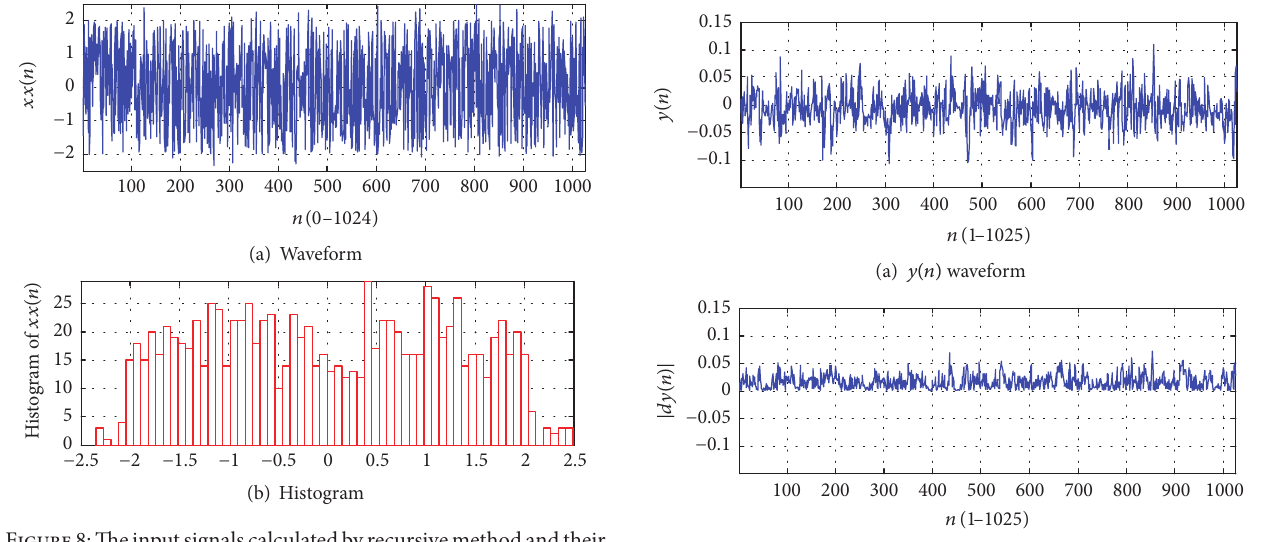
Figure8:Theinputsignalscalculatedbyrecursivemethodandtheir histogram.